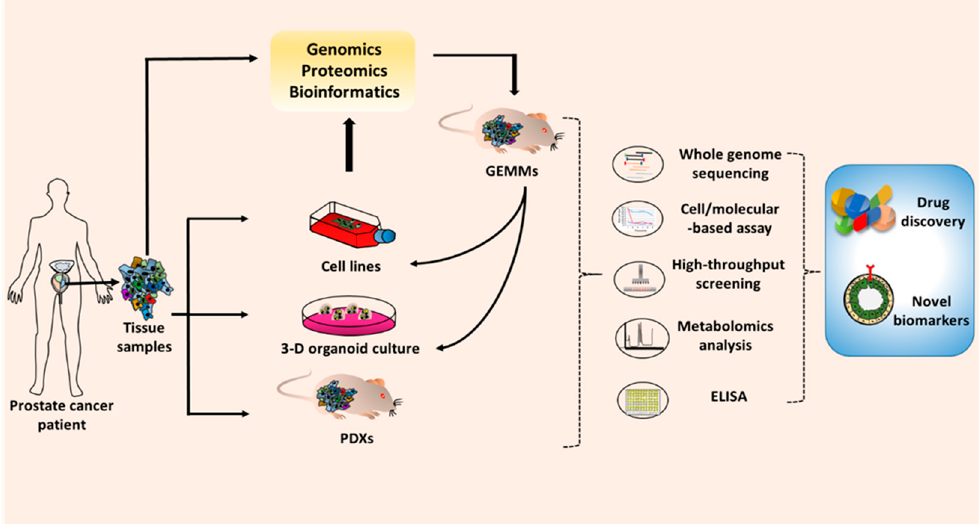
Figure 3. Application of the prostate cancer model in basic and preclinical cancer research. To develop the novel drugs or biomarkers, the prostate cancer models are required for in vitro and in vivo studies. The prostate cell lines, 3D-organiods, and patient-derived tumor xenografts (PDXs) can be generated from prostate tumor tissue from human patients. Patient tumor tissues can be also used to create genetically engineered mouse models (GEMMs). The results from research and preclinical studies are validated through several techniques such as whole genome sequencing, cell and molecular-based assays, high-throughput screening, metabolomics analysis, and ELISA. The promising drugs or biomarkers that emerge from those works will subsequently progress to preclinical and clinical studies.